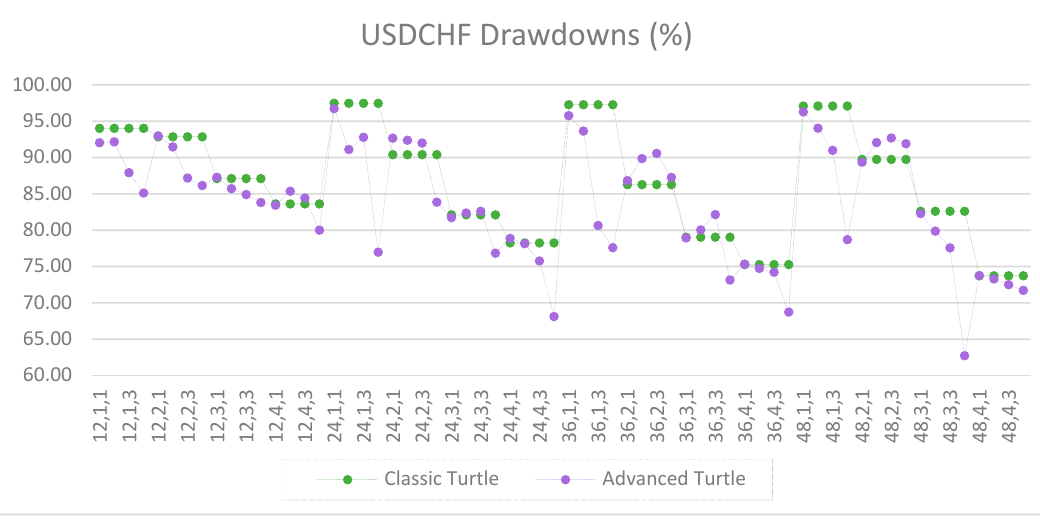
Figure A24. Drawdowns of USDCHF as percentage of equity between the classic and the advanced Turtle systems for every combination of N, X, Y for the medium parameters (40, 80).